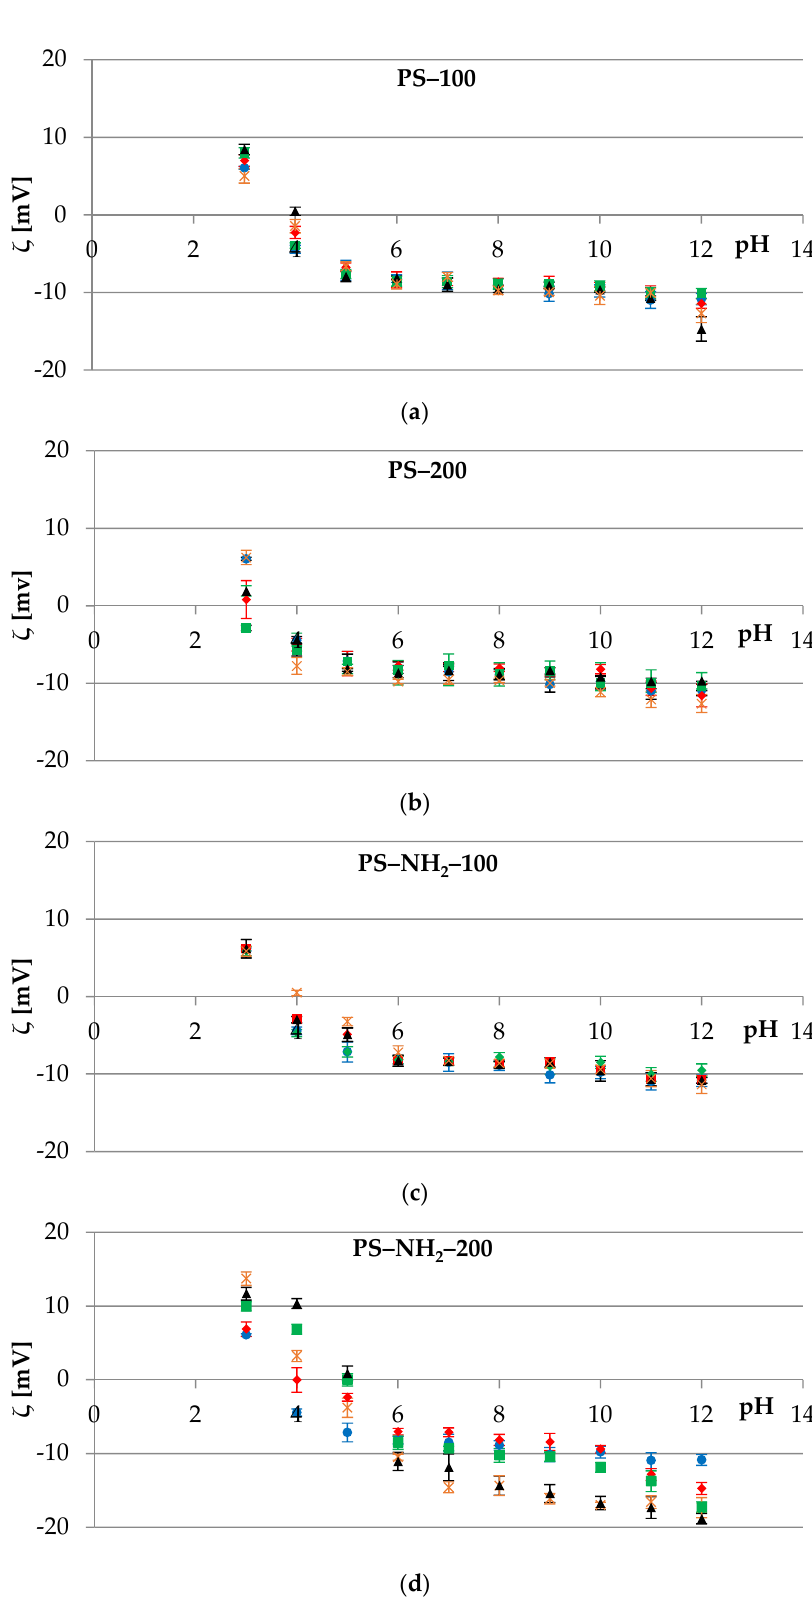
Figure 3. The zeta potential of the erythrocytes’ cell membranes as a function of the pH of the electrolyte solution. Membranes untreated ( ● ) or treated with 0.002 ( ♦ ), 0.01 ( ■ ), 0.1 ( ▲ ), and 0.5 ( × ) mg/mL of various types of polystyrene polymer: ( a ) PS–100, ( b ) PS–200, ( c ) PS–NH 2 –100, and ( d ) PS–NH 2 –200.